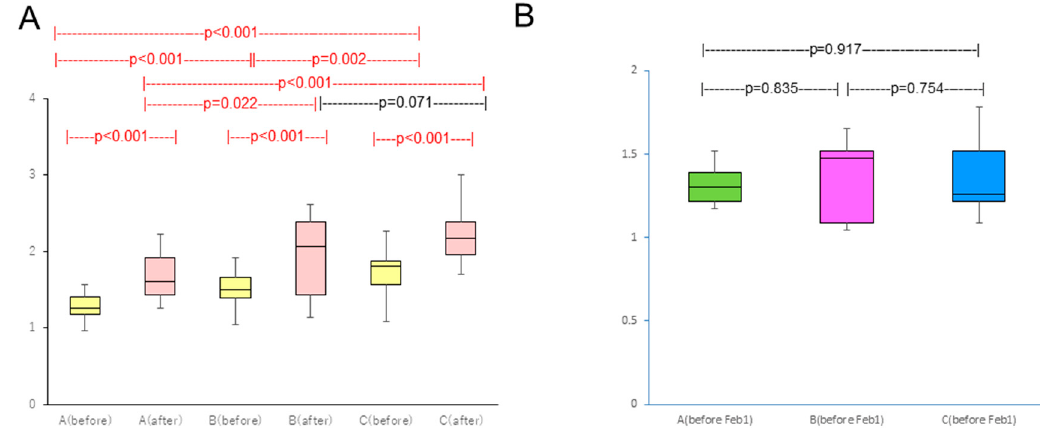
Figure 3. ( A ) Comparison of TNSS between before (January 27–February 23) and after pollen dispersion (February 24–March 28); ( B ) Comparison of TNSS between groups before study enrollment. Red bars indicate statistical significance.